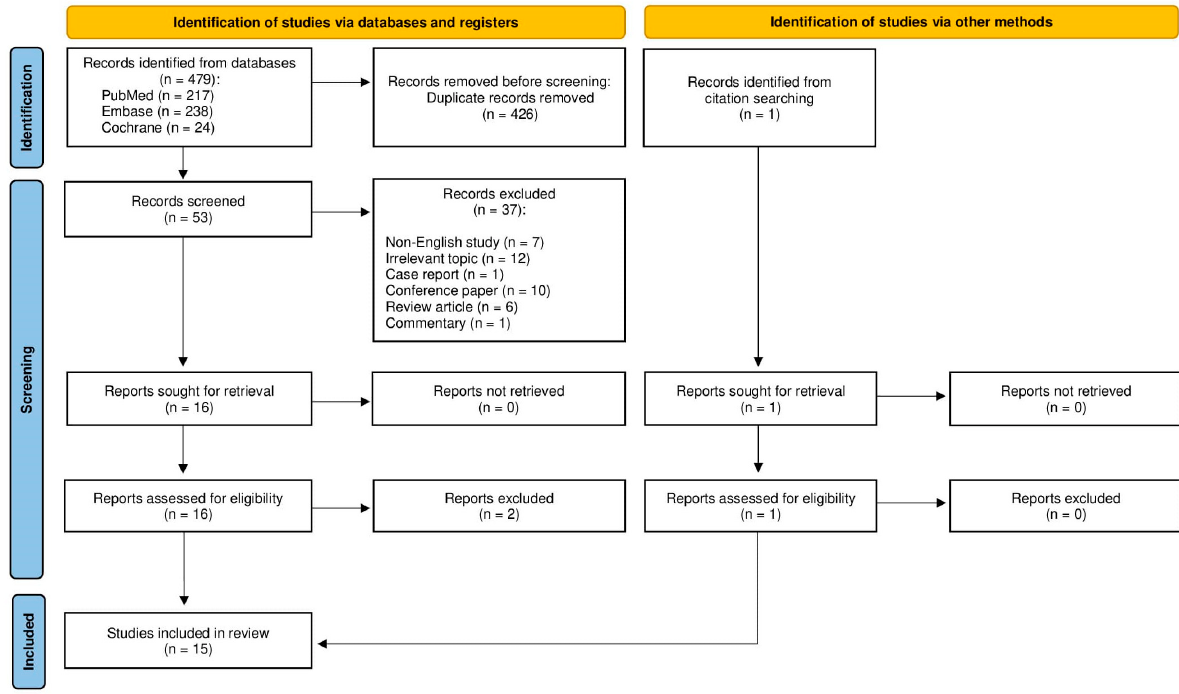
Figure 2. PRISMA flowchart of the medical database search strategy.